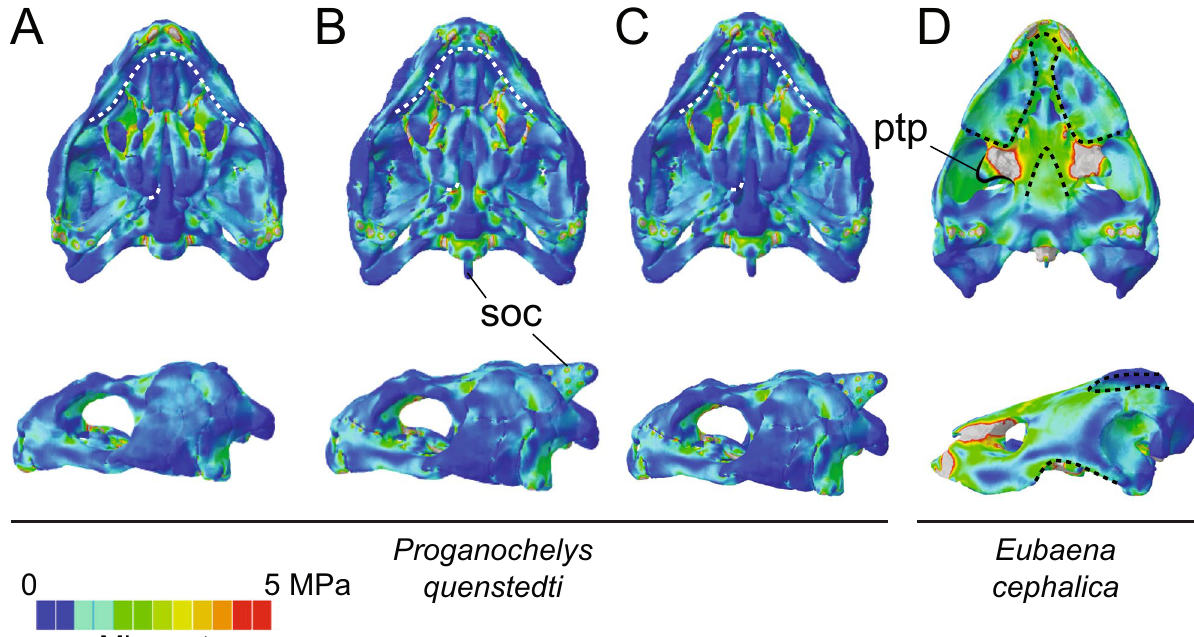
Figure 3. Ventral and left lateral von Mises stress contour plots for hypothetical models of † Proganochelys quenstedtii and † Eubaena cephalica . † Proganochelys quenstedtii with ( A ), basipterygoid suture, ( B ), supraoccipital crest, and ( C ), both modifications; ( D ), † Eubaena cephalica with a hypertrophied pterygoid process and both trochlear loads simulated. Contour plots are all scaled to the same size and 5 MPa peak stress. Dotted curves in ventral view, anteriorly and posteriorly, identify the triturating surface and the basipterygoid articulation/suture, and in lateral view the anteroventral and posterodorsal emarginations. Abbreviations: ptp, pterygoid trochlear process; soc, supraoccipital